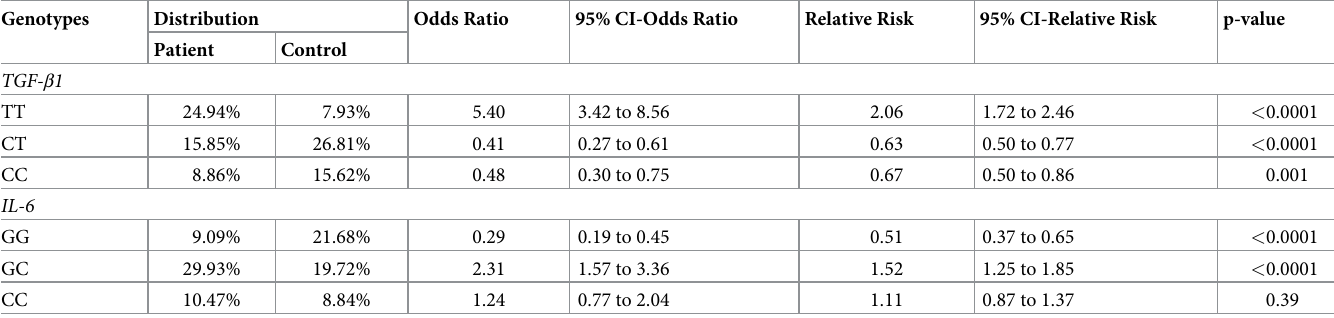
Table 5. Individual representation of TGF- β 1 +29C/T and IL-6 -174G/C genotypes amongst HCC and control groups.